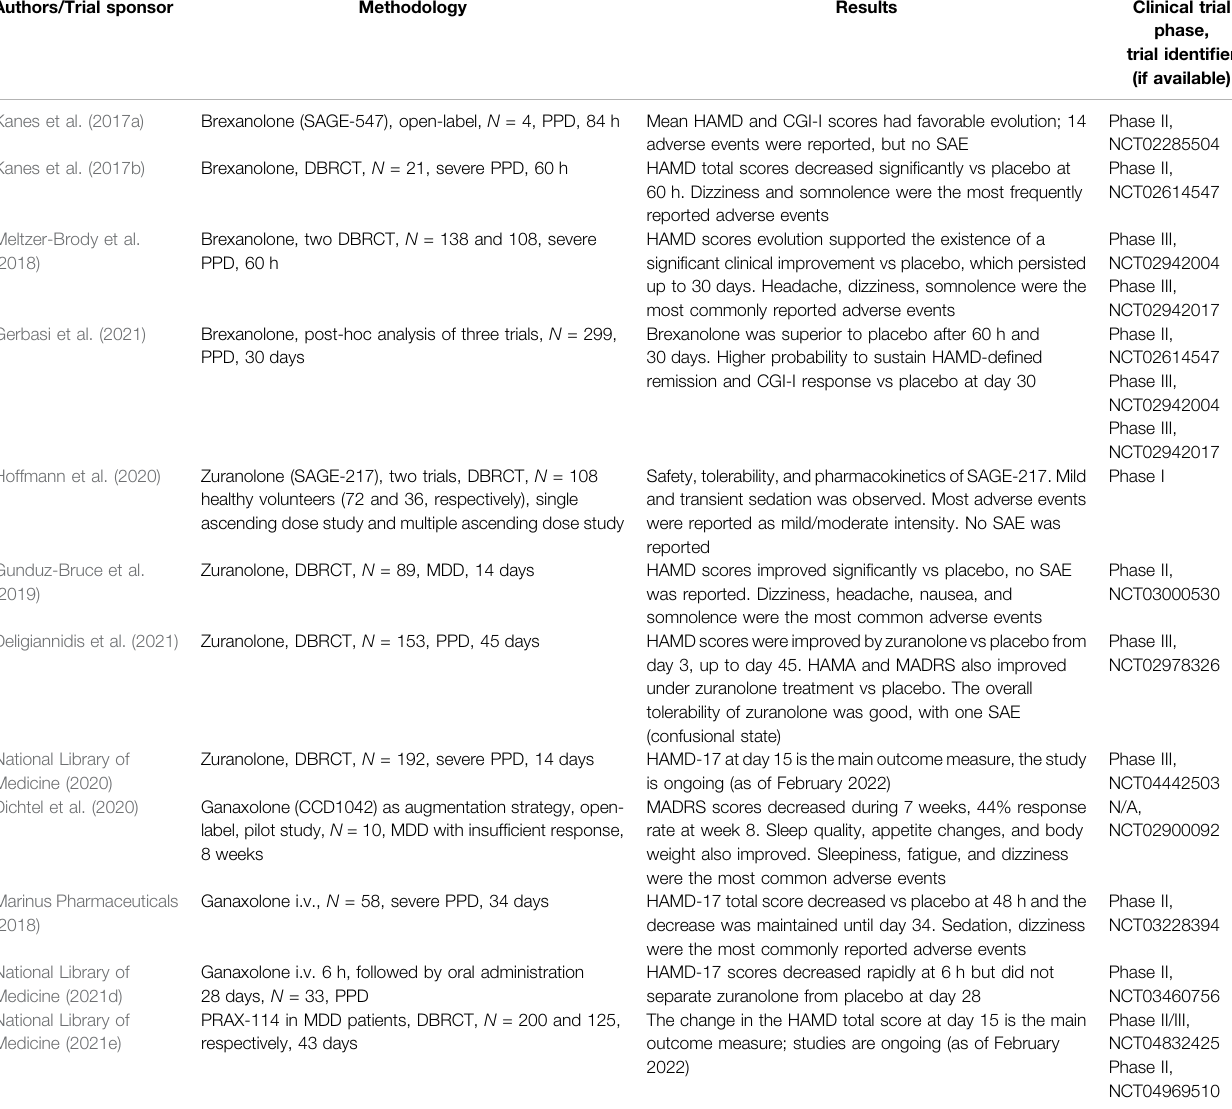
TABLE 5 | Neurosteroid analogs and GABA-A receptor modulators with antidepressant properties in the